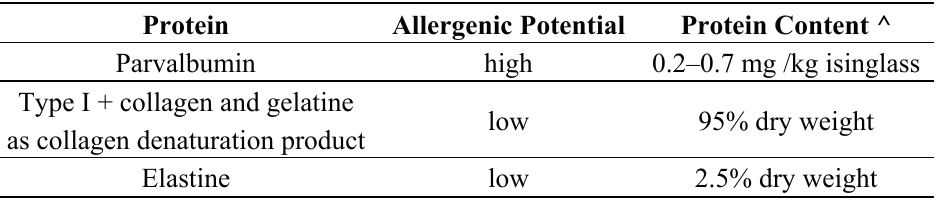
Table 5. Main proteins from isinglass and their allergenic